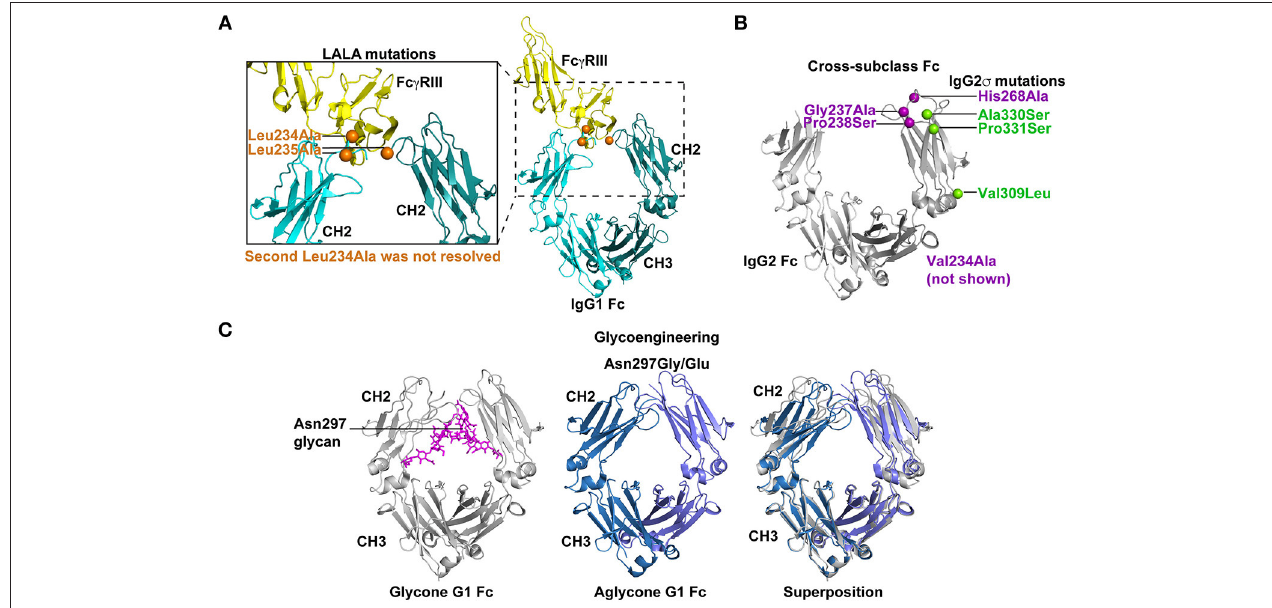
FIGURE 3 | Strategies for silencing antibody effector functions. (A) Point mutations in the Fc have been identified that disrupt antibody effector functions. The elucidation of key amino acids in the interaction of Fc with Fc γ Rs has led to collections of point mutations that can eliminate or drastically reduce Fc binding to specific Fc γ Rs. The Leu234Ala/Leu235Ala (LALA) mutations are perhaps the most commonly used mutations for disrupting antibody effector function ( 130, 131). As shown in the co-crystal structure (PDB: 1T83) with orange spheres the LALA mutations are proximal to Fc γ RIII (yellow) when it binds the IgG1 Fc (light and dark teal). These mutations can be combined with other effector function silencing strategies to engineer a Fc that is devoid of any Fc γ R binding or C1q binding. Leu 234 was only resolved in one of the chains of the Fc region. (B) Effector functions can be disrupted by exchanging amino acids between two Fc molecules from different IgG subclasses. These cross-subclass Fc designs rationally combine mutations that knockdown binding to a given Fc γ R or complement protein. IgG2m4 and IgG2 σ are two examples of engineered Fc regions that were generated by this approach ( 143, 144). IgG2 σ is perhaps the most effector function silent Fc and it combines cross-subclass mutations Val309Leu, Pro331Ser, and Ala330Ser (green spheres) with four additional mutations not naturally found in human Fc sequences (purple spheres) ( 144). The crystal structure of the IgG2 Fc (gray) encoding these mutations (green and blue spheres) showed the CH2 domains moved farther apart from each other. Also, Asp270 and Pro329, which are essential for binding to Fc γ R and C1q, were repositioned (PDB:4L4J; 145). Position 234 was not visible in the crystal structure and is not shown in figure. (C) Removal of the Asn297 glycan in the IgG Fc severely reduces Fc binding to Fc γ Rs by inducing a Fc closed conformation. Several Fc designs have removed the N-linked glycosylation site at position 297 by introducing Asn297Gly or Asn297Glu changes ( 151, 152). The crystal structure of glycosylated IgG1 Fc (gray) is shown with the N297 glycan (magenta; PDB:4BYH). The introduction of a Gly or Glu residue at position 297 produces an aglycone IgG1 Fc (blue and lilac; PDB:3S7G). Superposition of the glycone and aglycone Fc crystal structures shows the lilac and blue CH2 domains in the aglycone are closer in proximity than the gray CH2 domains. The altered CH2 conformation has been hypothesized to be the structural explanation for reduced Fc γ R binding by the aglycone